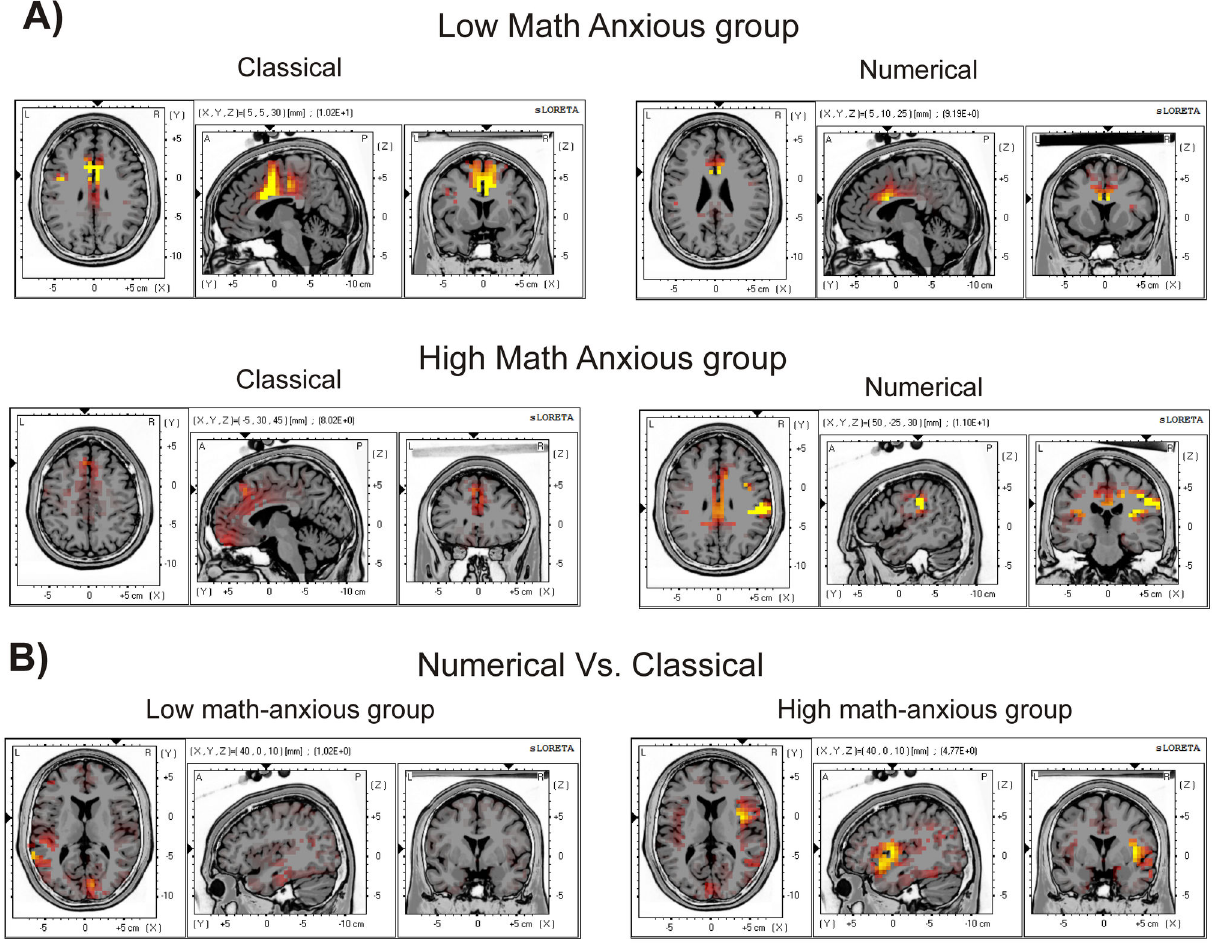
Figure 5. Images of neural activity computed with sLORETA. The images represent cortical areas showing significant activation (p < .01) for the ERN (50-90 ms window) for the LMA and the HMA group in the numerical and the classical Stroop task (A) and areas showing significant differences (p < .05) between the classical and the numerical Stroop tasks for the LMA and the HMA groups